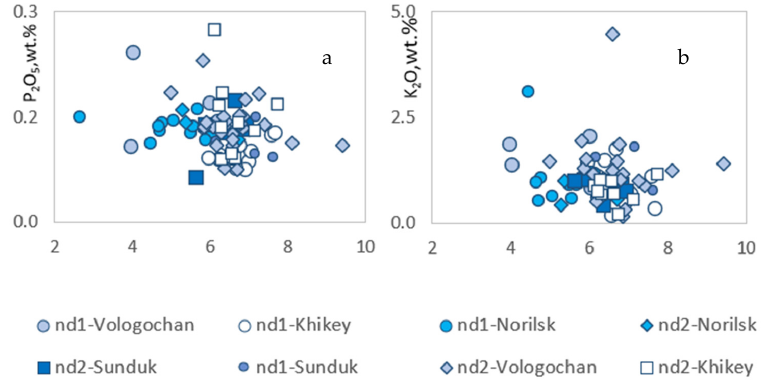
Figure 14. Diagrams (La/Sm)n vs. (Gd/Yb)n ( a ) and (U/Nb)n vs. (La/Yb)n ( b ) for the rocks of the Nadezhdinsky Formation. Captions in Figure 13.